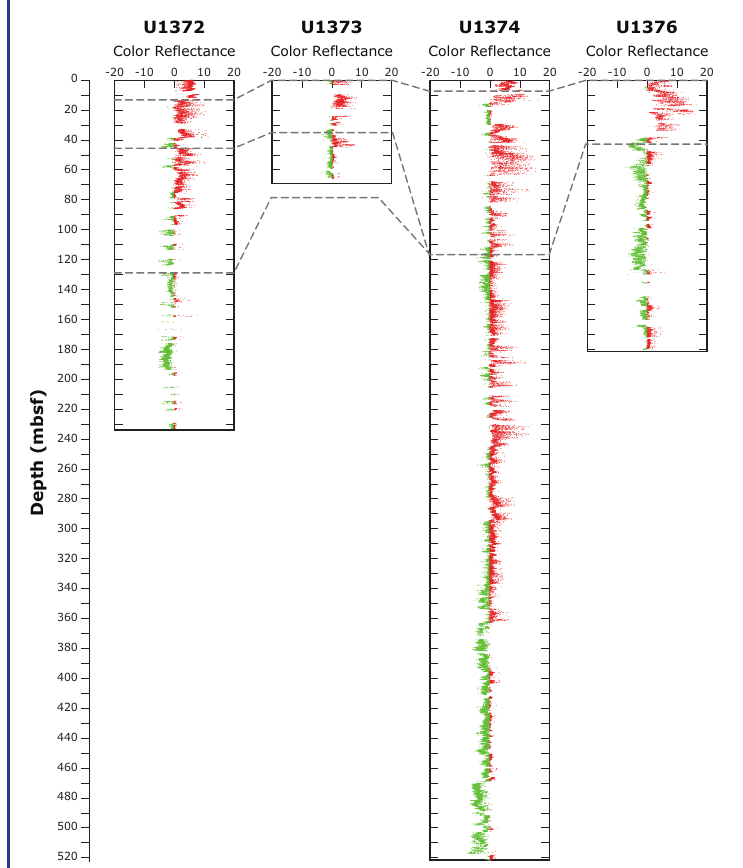
Figure 5. Compilation of downhole alteration color showing transitions from submarine to subaerial volcanic environments. The drilled sequences of Sites U1372 (Canopus Guyot), U1373 and U1374 (Rigil Guyot), and U1376 (Burton Guyot) are displayed showing color reflectance values downhole. Green colors typically would be interpreted as basalt formation under more reducing conditions (i.e., submarine) and red colors as formation under more oxidizing conditions (i.e., subaerial). Downhole data plots for Sites U1375 and U1377 are omitted because of the shallow penetration depths. Figure after Koppers et al.